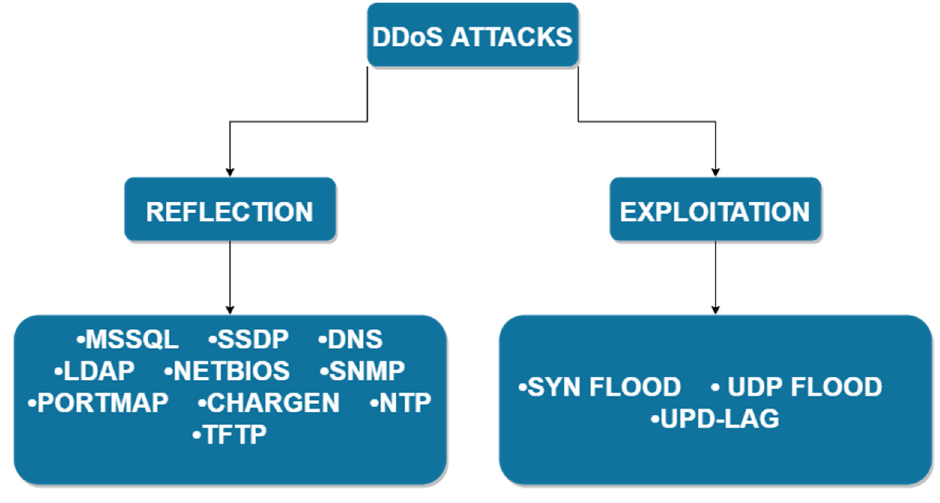
Figure 1. DDoS attack taxonomy